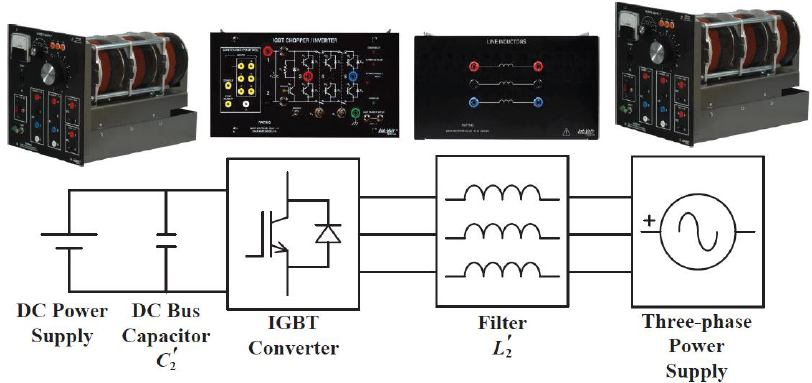
Figure 8. The configuration of the inverter controller experiment.